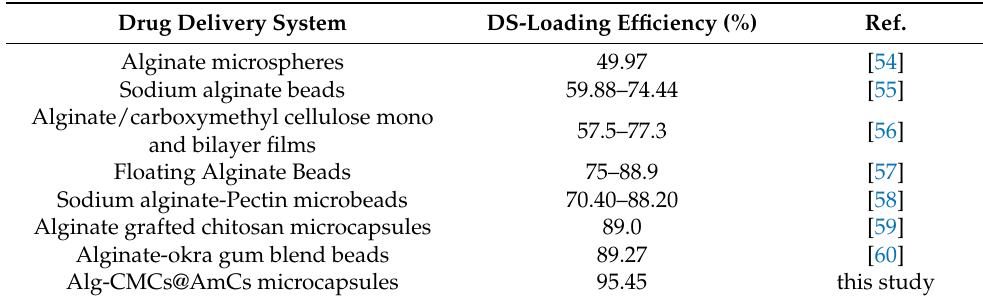
Figure 5. DS-loading efficiency values for Alg (S0), Alg-CMCs single PEC (S1-S3) and Alg-CMCs@AmCs dual PECs (S4–S6) microcapsules. Values were presented as means ± S.D ( n = 3), and significant data were determined at p -value ≤ 0.05. Table 3. Comparison of DS-loading efficiency of Alg-CMCs@AmCs microcapsules with other reported drug delivery systems-based alginate biopolymer.